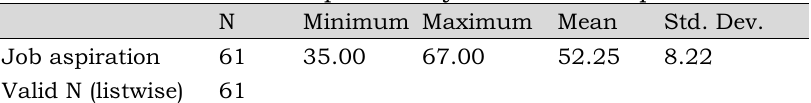
Table 4. Descriptive analysis of career aspiration